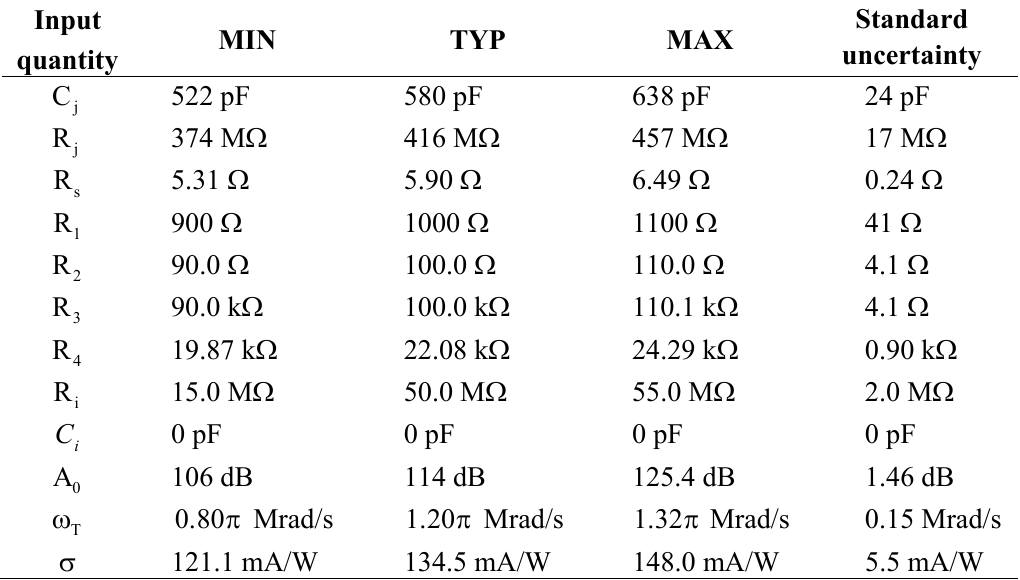
Table 1. Minimum, typical, maximum value and standard uncertainty of the input